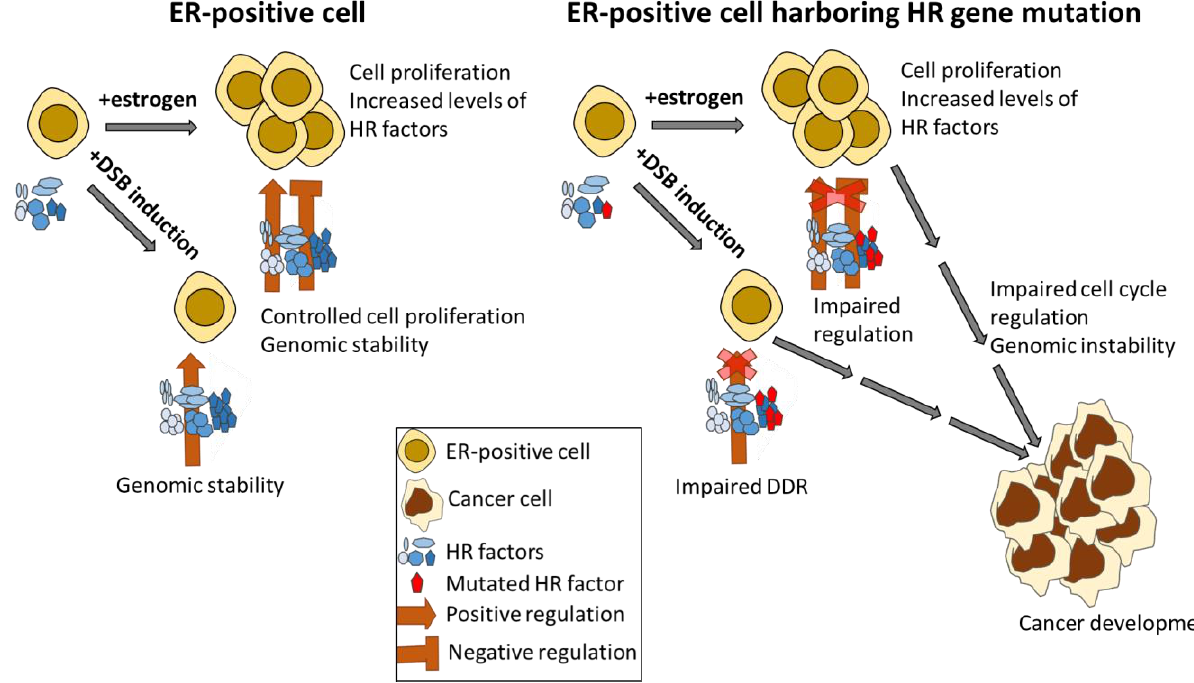
Figure 3. A model that depicts the interplay between estrogen, HRR factors, DNA damage and DDR and suggests how this interplay triggers estrogen-dependent cancer formation in cells harboring mutation in HRR genes. ER-positive cells contain a basal level of mRNA encoding HRR factors. Upon supplementation of estrogen or due to DSB formation, the level of these mRNAs is elevated. Addition of estrogen results in cell proliferation, which is tightly regulated, both positively and negatively, by DDR factors, to ensure controlled cell proliferation and genomic stability. Incensement in HRR factors due to DSB induction in ER-positive cells deprived of estrogen will upsurge the activity of the HRR pathway to ensure genomic stability. In cells harboring a mutation in one of the HRR genes, there is only a partial augmentation of HRR genes, resulting in insufficient activity of the HRR pathway. These will lead to impaired cell cycle regulation and genomic instability that may trigger cancer development.